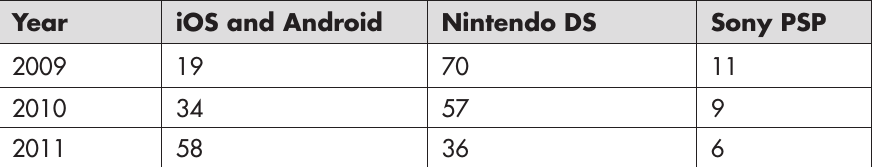
Table 1 U.S. portable game software by revenue